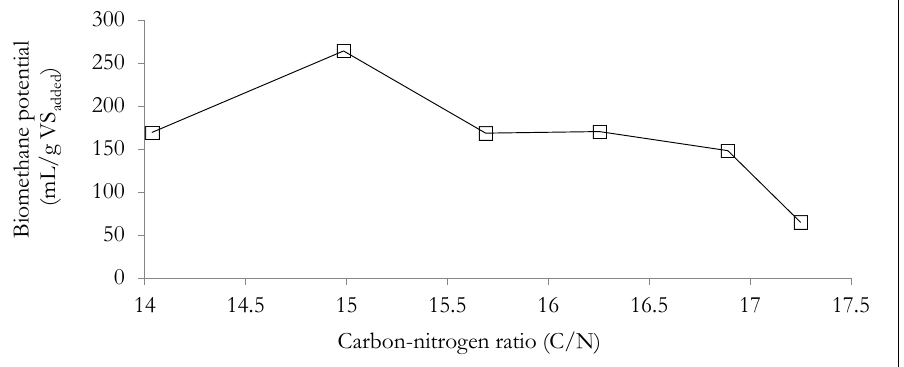
Figure 7. Analyzing the effect of C/N ratio on biomethane yield.